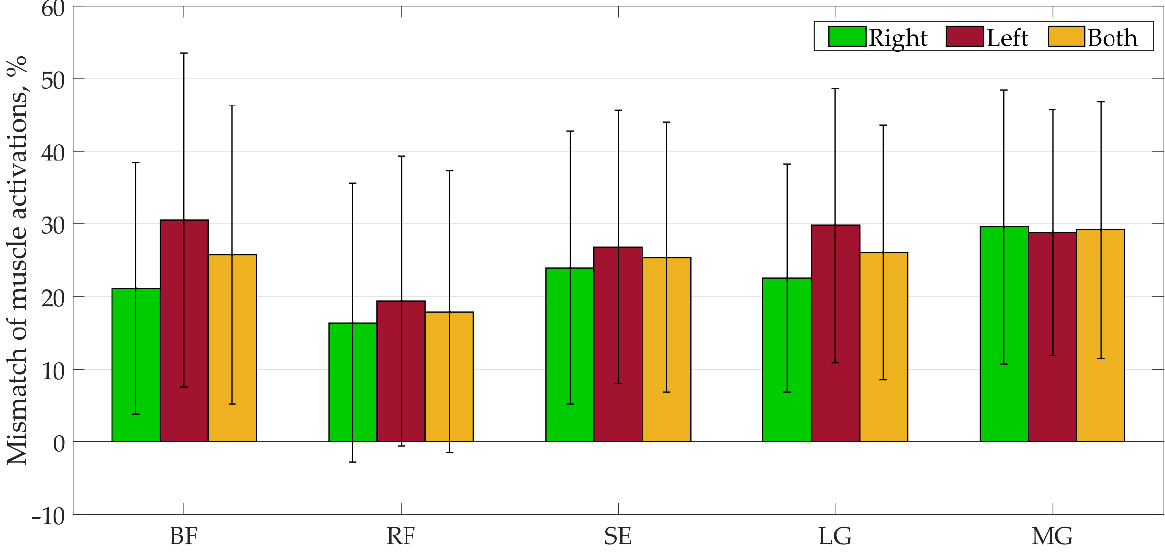
Figure 5. Results of the SPM analysis for all subjects. Data are presented as mean ± SD.